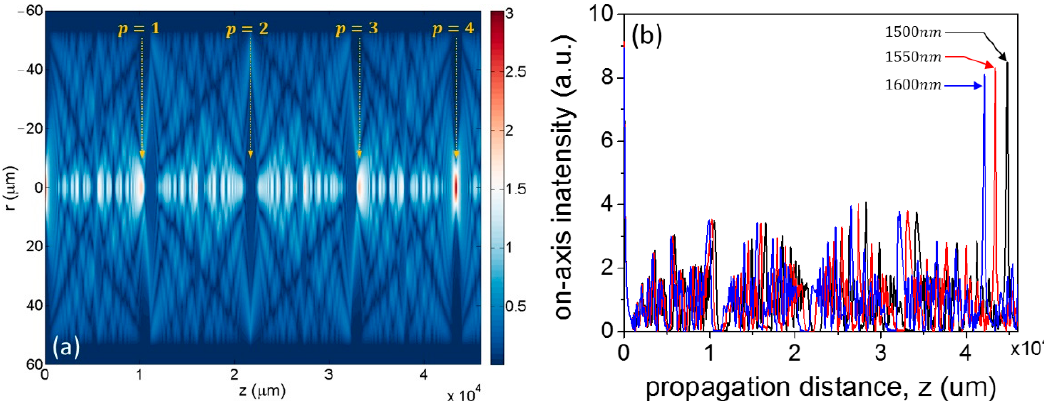
Figure 3. ( a ) Field intensity of the MMI pattern in an SMF-MMF arrangement. The structure was simulated at a free-space wavelength of 1550 nm for SMF/MMF with core diameters of a = 8.6/105 µm and numerical apertures of NA = 0.12/0.22, respectively. The distance z indicates the propagation distance in the MMF, i.e., z = 0 represents the interface between the SMF and the MMF. ( b ) On-axis (r = 0) intensity for the same structure at different free-space wavelengths (1500, 1550, and 1600 nm) showing a sharp image of the input field at 𝑝 = 4 .